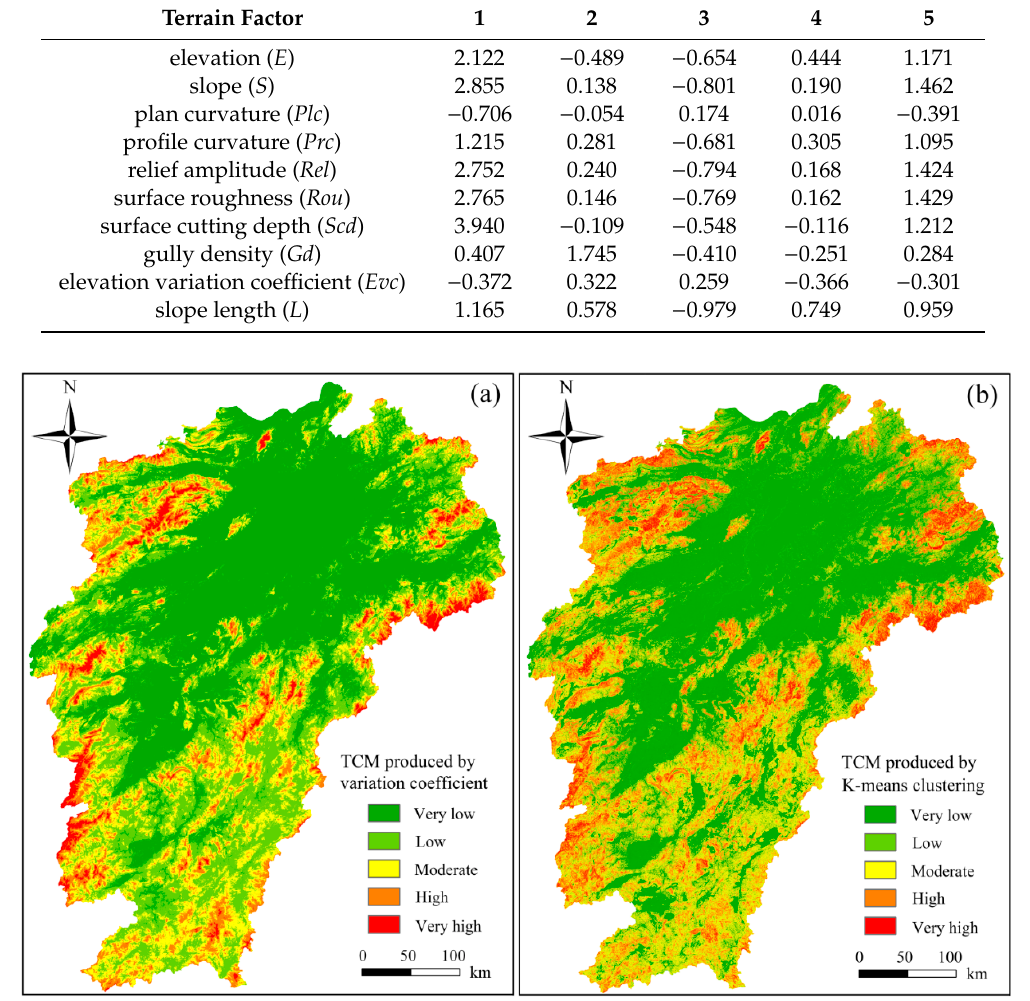
Figure 5. TCMs produced by variation coefficient method ( a ) and K-means clustering model ( b ). Table 5. TCA results of the four models.